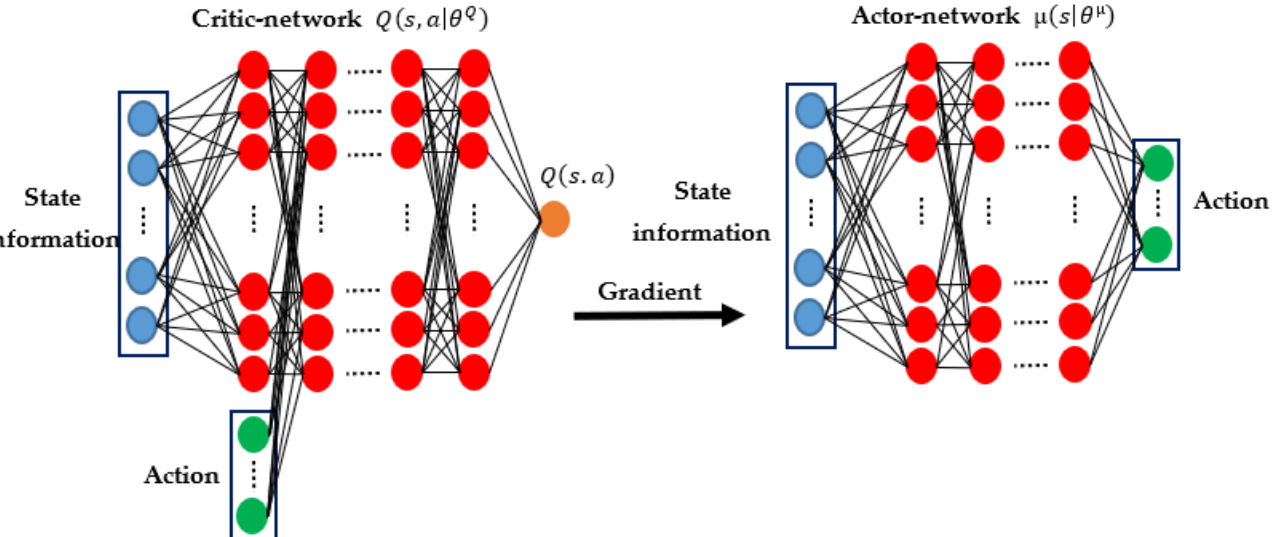
Figure 2. Actor–critic neural network structures for DDPG.